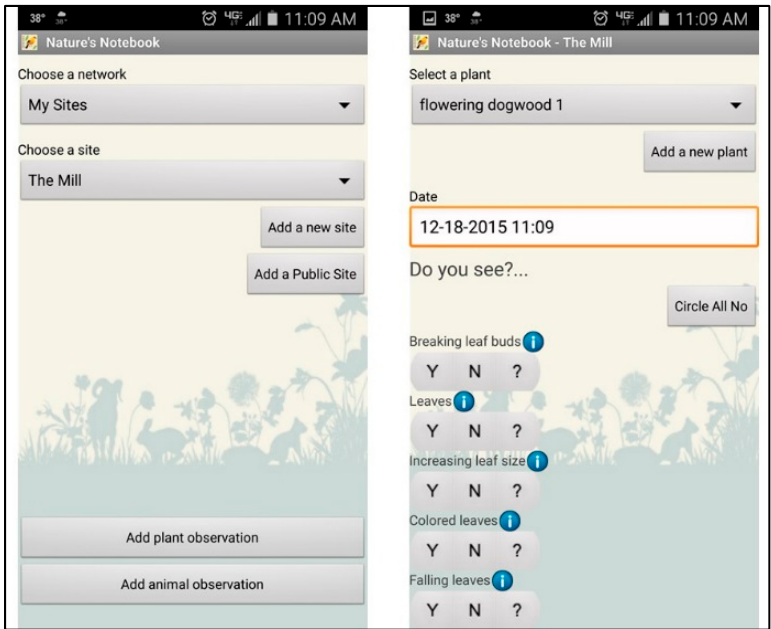
Figure 5. Screenshot of NPN Nature’s Notebook Mobile App for reporting vegetation phenology.